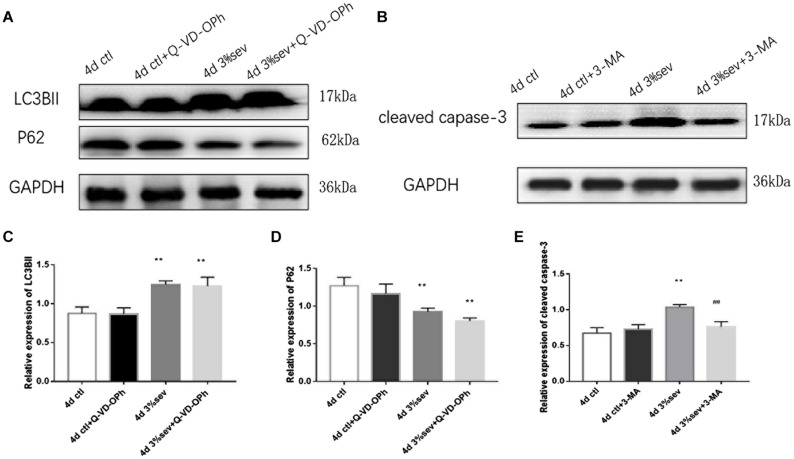
(A) LC3B inhibitor alleviated sevoflurane-induced cleaved caspase-3 expression in DG region 4 days after anesthesia. (B) Caspase-3 inhibitor did not affect sevoflurane-induced LC3BII expression in DG region 4 days after anesthesia. (C) Quantification of LC3BII. (D) Quantification of P62. (E) Quantification of cleaved caspase-3. n = 3. Values are presented as mean ± SD; **P < 0.01 compared with the control 4 days group, ##P < 0.01 compared with the 4 days sevoflurane group. One-way ANOVA with Newman–Keuls post hoc test or Kruskal–Wallis with Dunn’s multiple comparison test was used for data analysis.